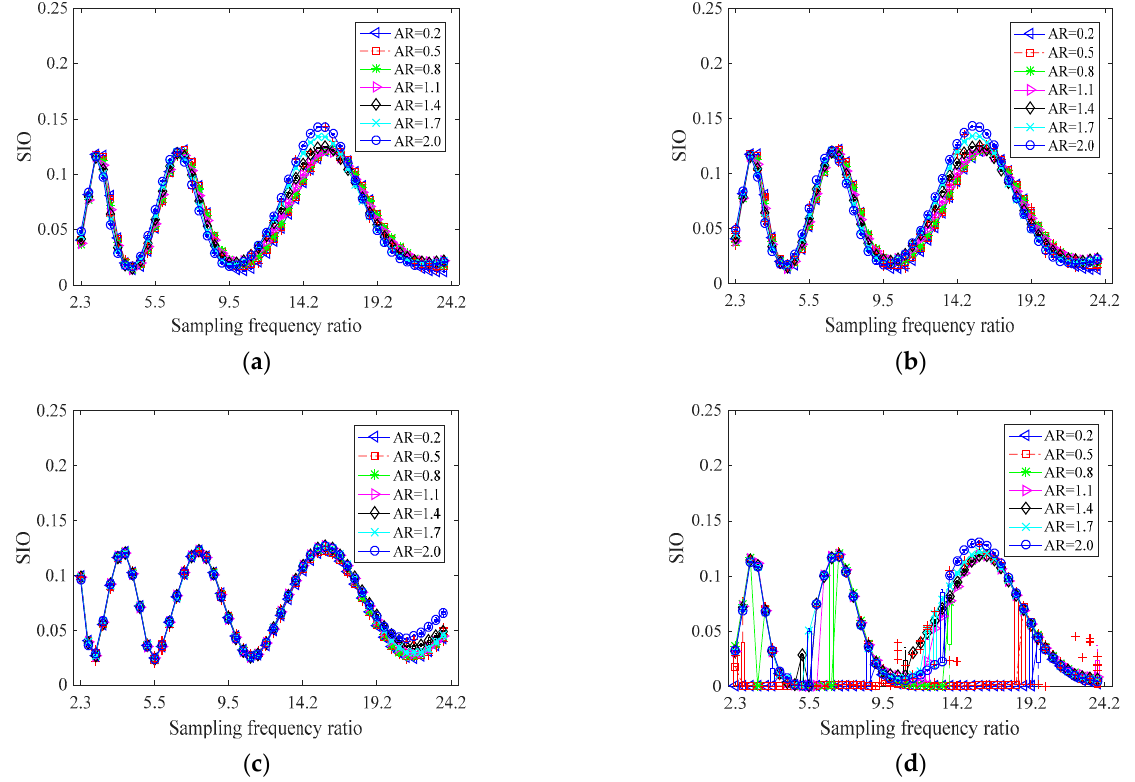
Figure 7. SIO of the sinusoidal component in the original signal for the four noise-assisted EMD algorithms: ( a ) EEMD; ( b ) CEEMD; ( c ) CEEMDAN; ( d ) ICEEMDAN.